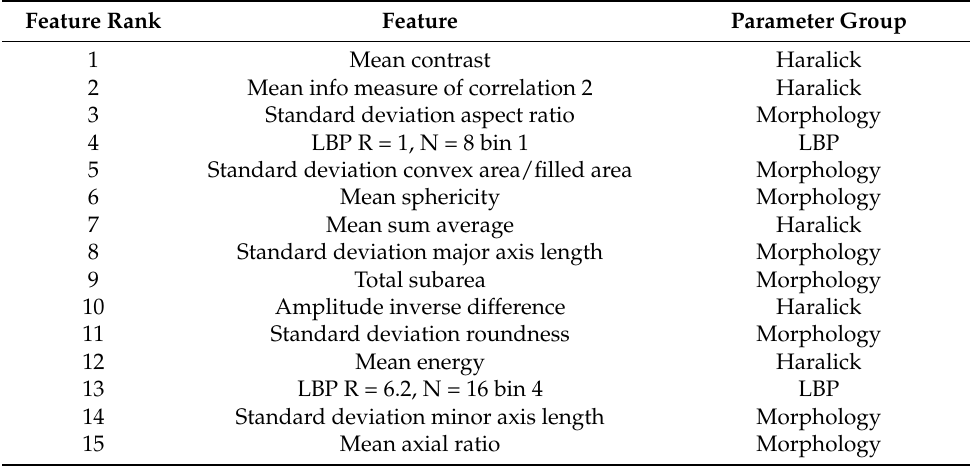
Table 8. Top 15 features after MRMR algorithm feature